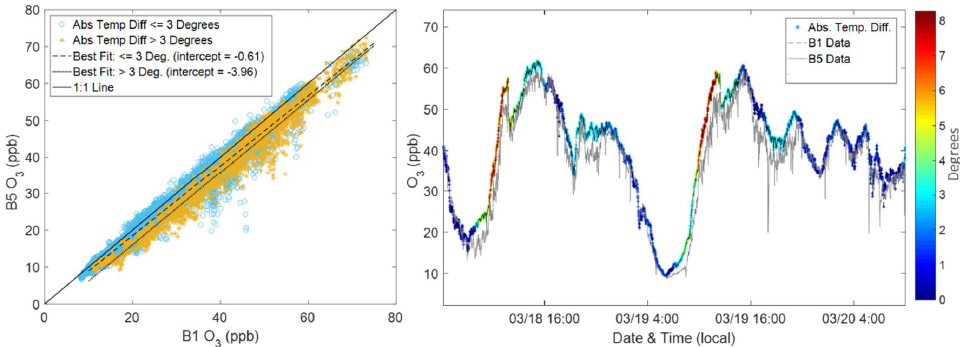
Figure 8. Two plots illustrating the effect of temperature differences between the pods. The scatter plot ( left ) depicts B1 vs. B5, separating points where the temperature difference between the two pods is less than and greater than three degrees Celsius. The time series ( right ), shows two days of data from B1 and B5 where the B1 data also has an overlay of temperature differences between the pods.